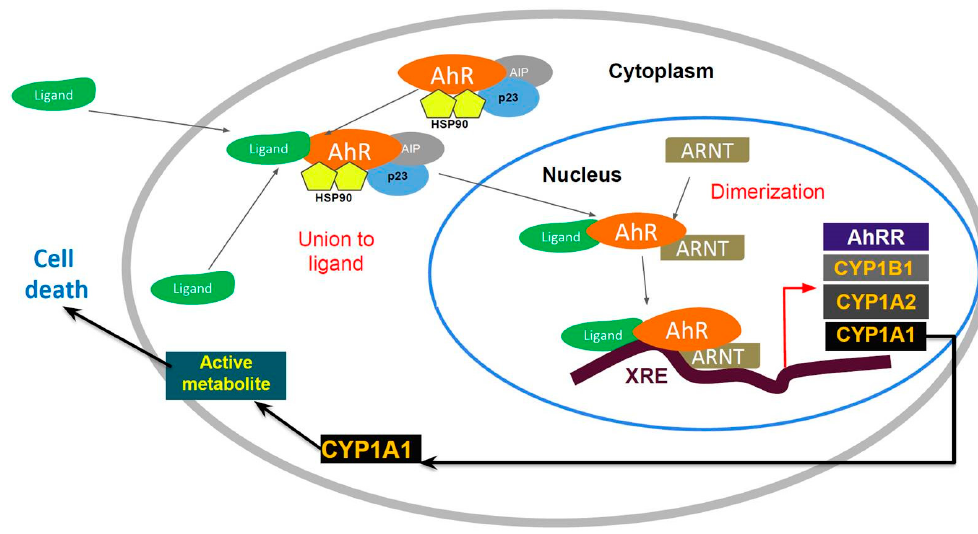
Figure 1. The aryl hydrocarbon receptor (AhR) signaling pathway.